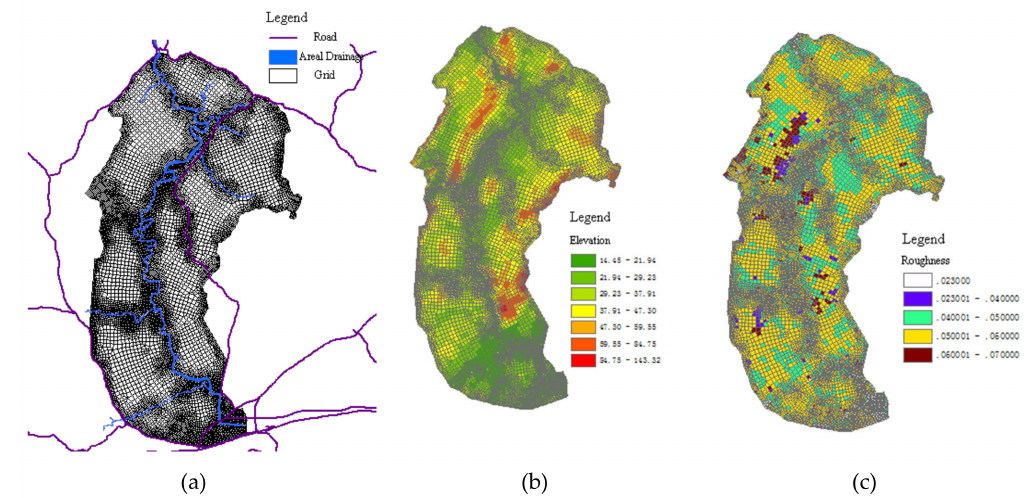
Figure 3. ( a ) Constructed mesh. ( b ) Elevation distribution. ( c ) Roughness